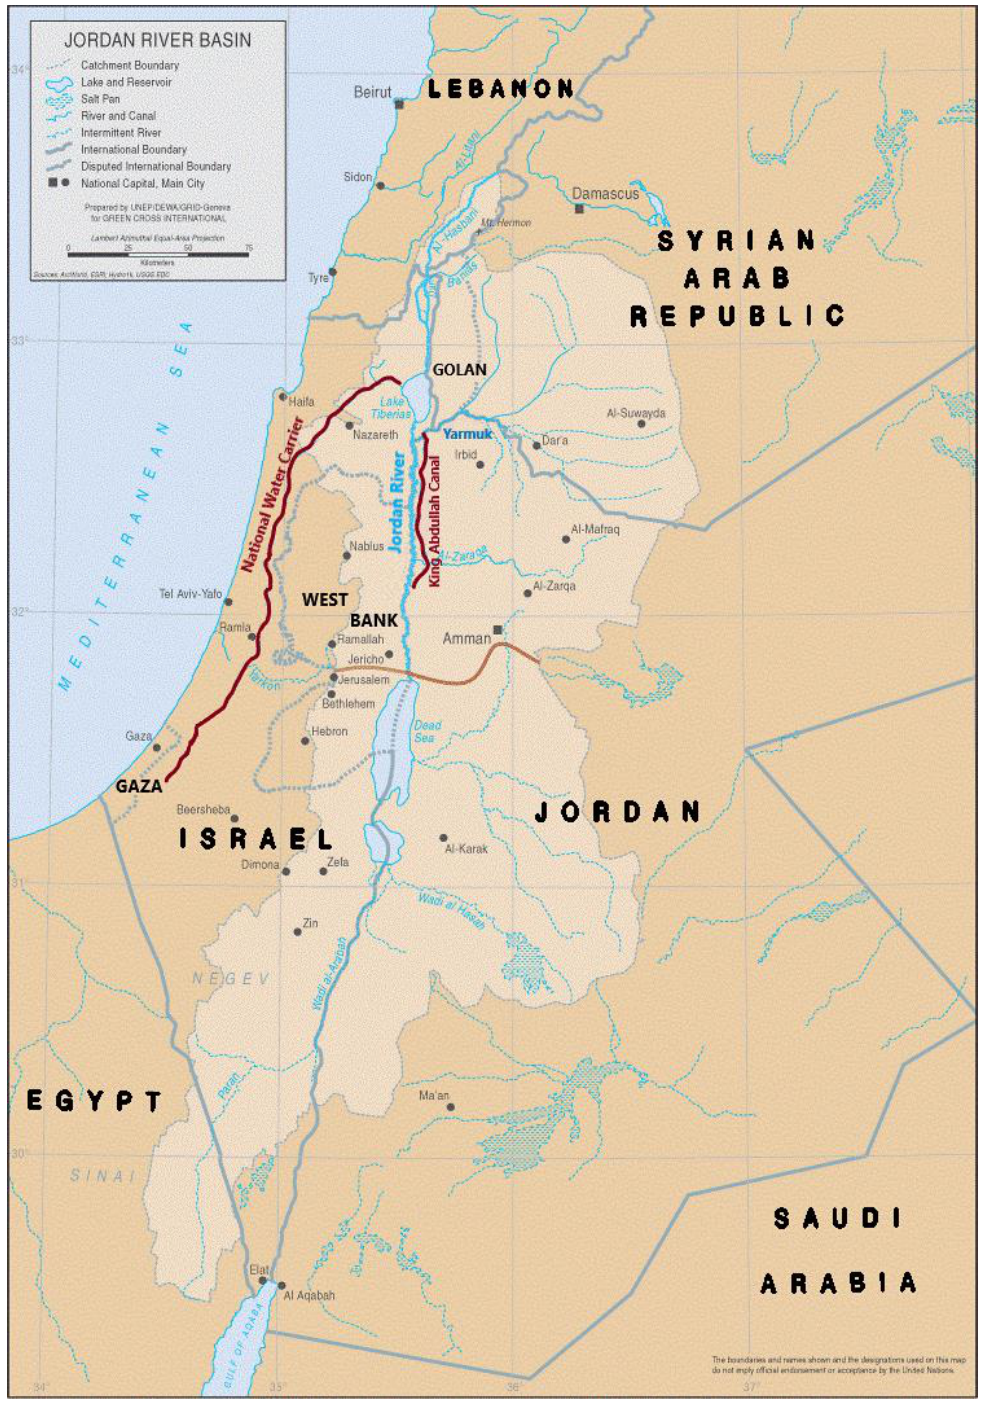
Figure 1. Jordan River Basin. Adapted from: UNEP, 2001. https://unepgrid.ch/en/resource/137 (accessed on 16 August 2021).